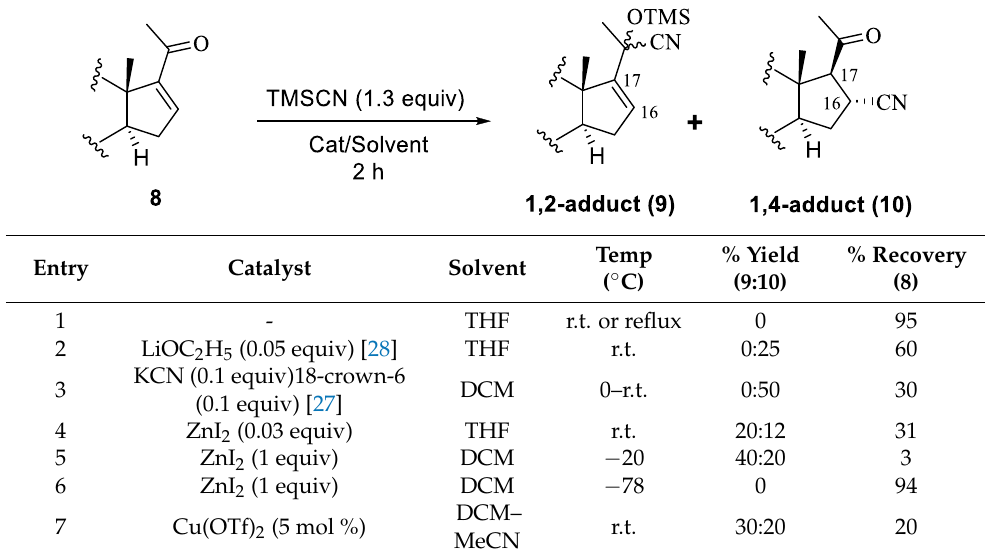
analogs (NO-CIETA) 14a , b .